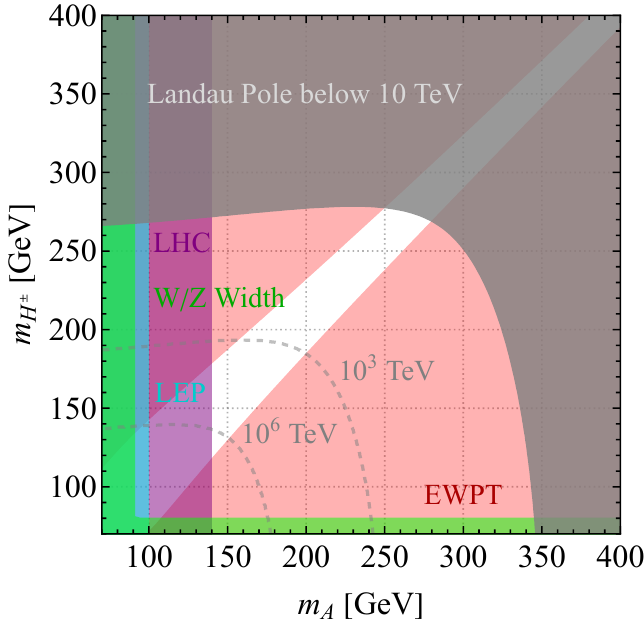
Figure 3 . Experimental constraints on the charged and pseudoscalar Higgs masses in the r (cid:28) 1 regime for m sin( β − α ) , tan − 1 β ≈ 0 and λ = 0 . 01 fixed to its maximal allowed value. The h , 345 white region shows the allowed parameter space. In red we show the 2 σ bounds from electroweak precision tests as discussed in section 4.1. The region shaded in gray corresponds to parameter values which develop a Landau pole in the scalar quartics below 10 TeV. For reference we also show as dashed lines how far this region would extend in order to prevent a Landau pole below a scale of 10 3 , 10 6 TeV. The green region is excluded by W and Z width measurements which forbid unsuppressed W ± → H ± h and Z → hA decays. The cyan and purple shaded regions are bounds from recast LEP-II limits for neutralino production [56] and LHC dilepton searches [57],